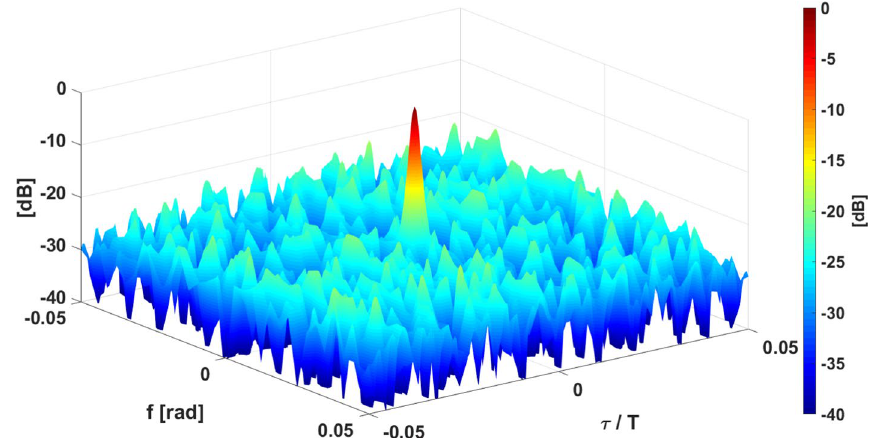
Fig. 7 Ambiguity function in decibel (dB) of a noise waveform. BT